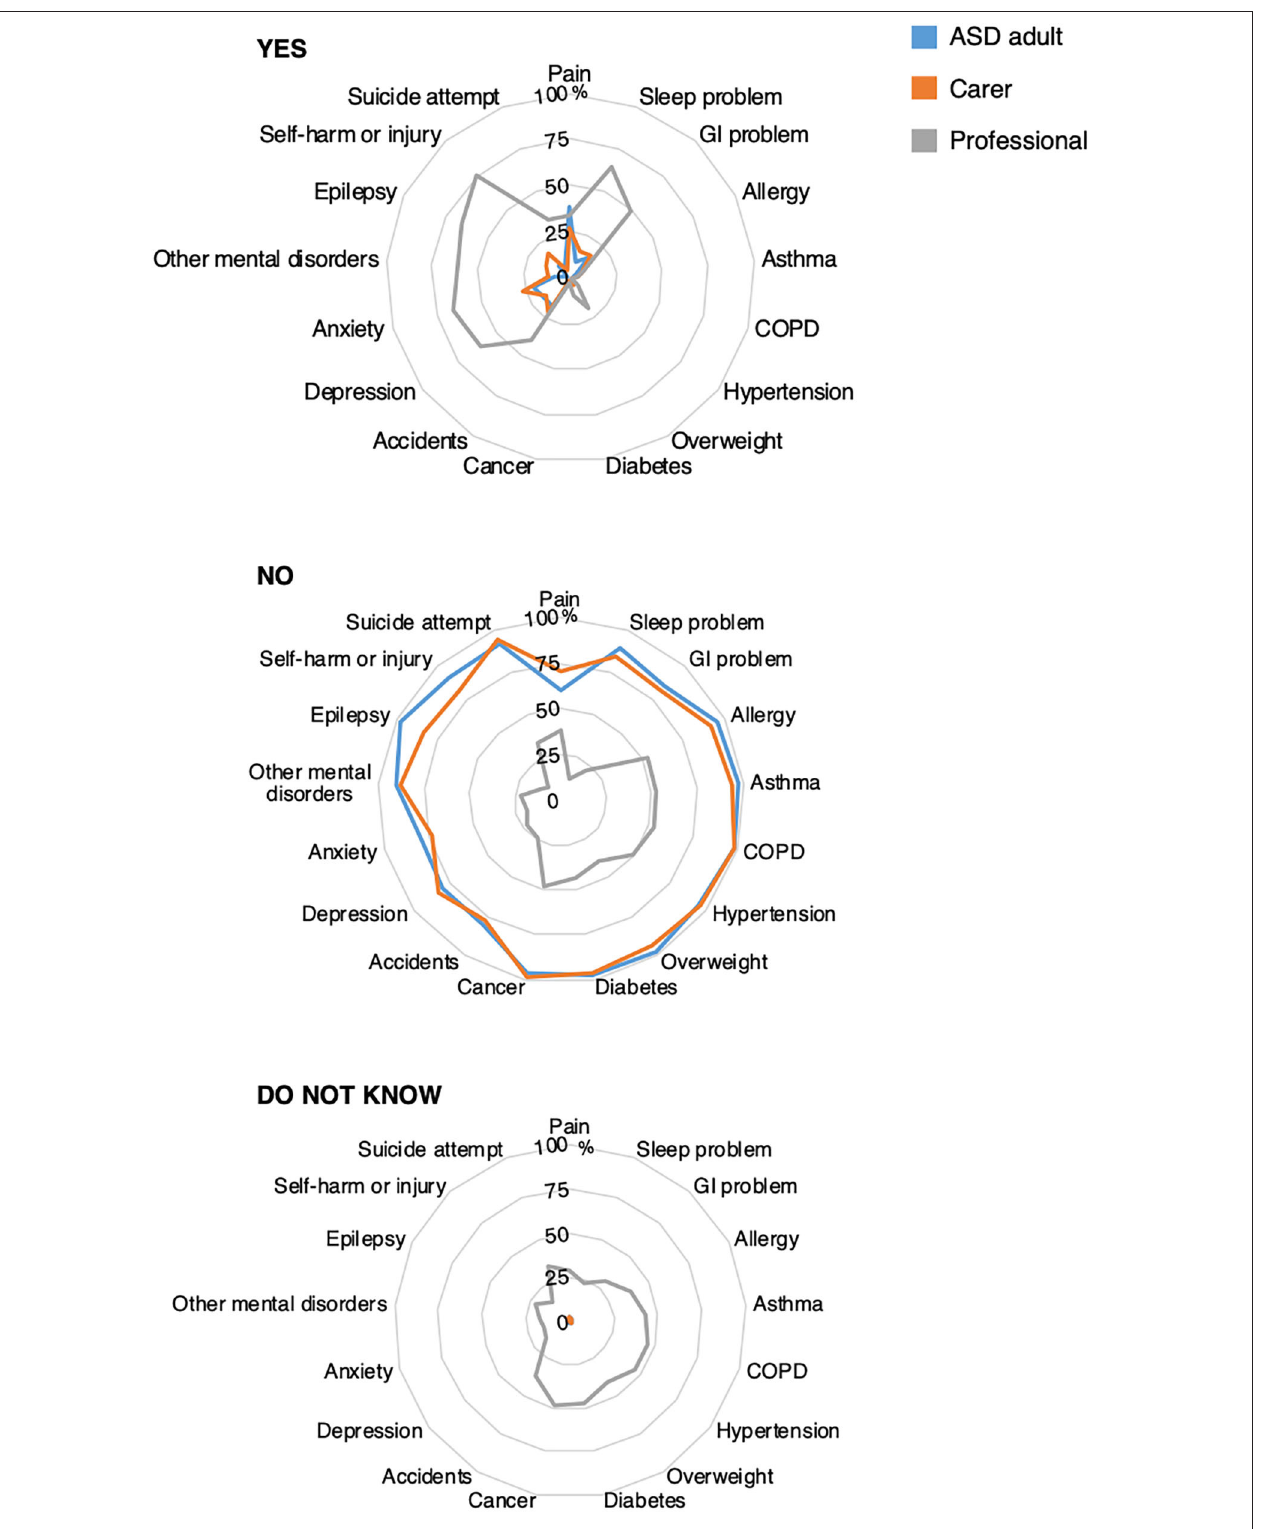
FIGURE 4 | Reason for most recent hospital contact. GI, gastrointestinal; COPD, chronic obstructive pulmonary disease; ADHD, attention-deficit hyperactivity disorder. Radar chart plots of the answers “YES,” “NO,” and “Do not know” at the following questions: “What was the reason for the most recent hospital contact?” (autistic adults, blue line); “What was the reason for the adult’s most recent hospital contact?” (carers, orange line) and “… Do you believe that the following reasons for hospital contacts are more frequent in autistic adults, compared with adults not on the autism spectrum?” (Professionals, gray line). Values expressed as percentages. N autistic adults: 273 to 274; N carers: 187 to 200; N professionals: 108. Infection is not displayed in the figure since it is not a chronic condition.